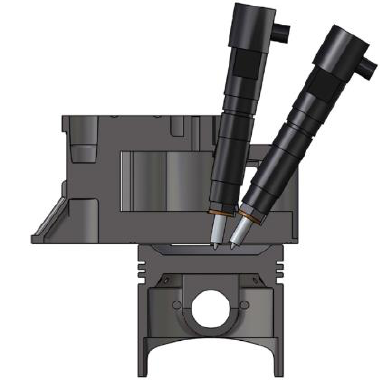
Fig. 12. Diagram of the JCCI combustion system design (reproduced from